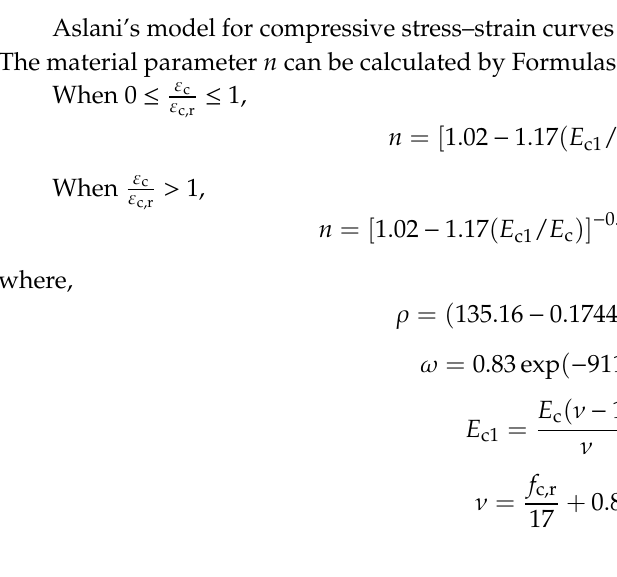
Figure 17. Relationship between ε cu / ε c,r and α c / α c,f.